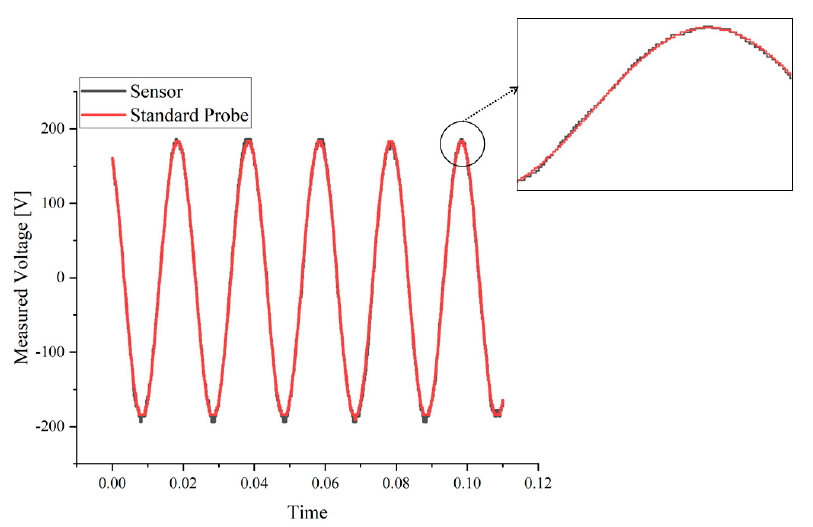
Figure 15. Comparison of the reconstructed voltage of the homemade sensor and the measured output of the standard probe.